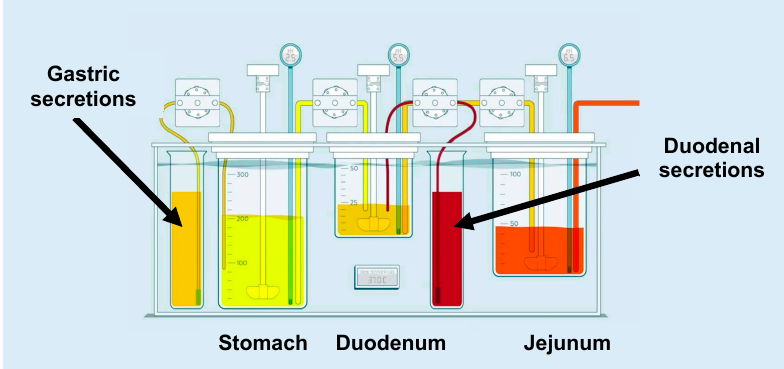
Figure 1. Setup and design of the gastrointestinal simulator (GIS) that was applied to test the different formulations of dexketoprofen trometamol (DKT) in fasted state conditions. Figure adopted from Hens and Bermejo et al. [4] with permission. Copyright Elsevier